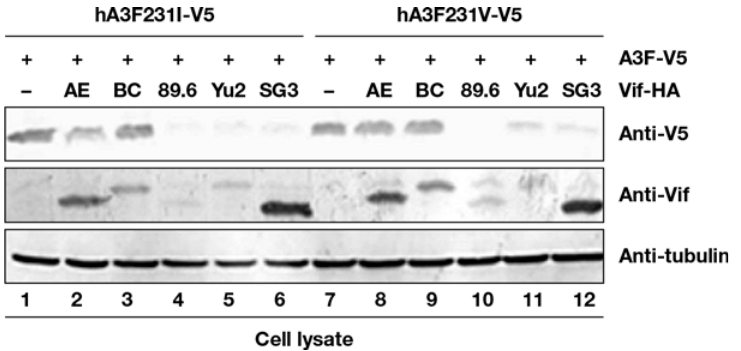
Fig 5. Influence of HIV-1 Vif on A3F variant protein expression. HEK293T cells in 12-well plate were co- transfected with 1 μ g of Vif expression vector or a control vector, plus 0.3 μ g of A3F-231I-V5 expression vector encoding a V5-tagged A3F231I protein (lanes 1 – 6), or plus 0.3 μ g of A3F231V-V5 expression vector encoding a V5-tagged A3F-231V protein (lanes 7 – 12). At 48 h after transfection, cell lysates were harvested for immunoblot analysis with indicated